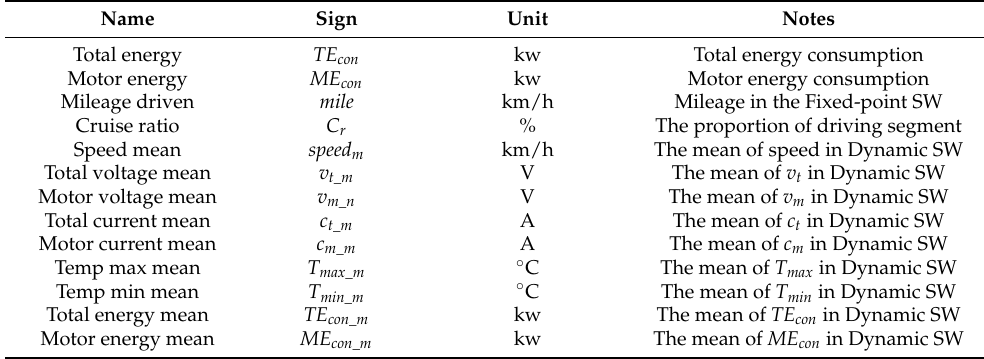
Table 2. Summary of the extended features